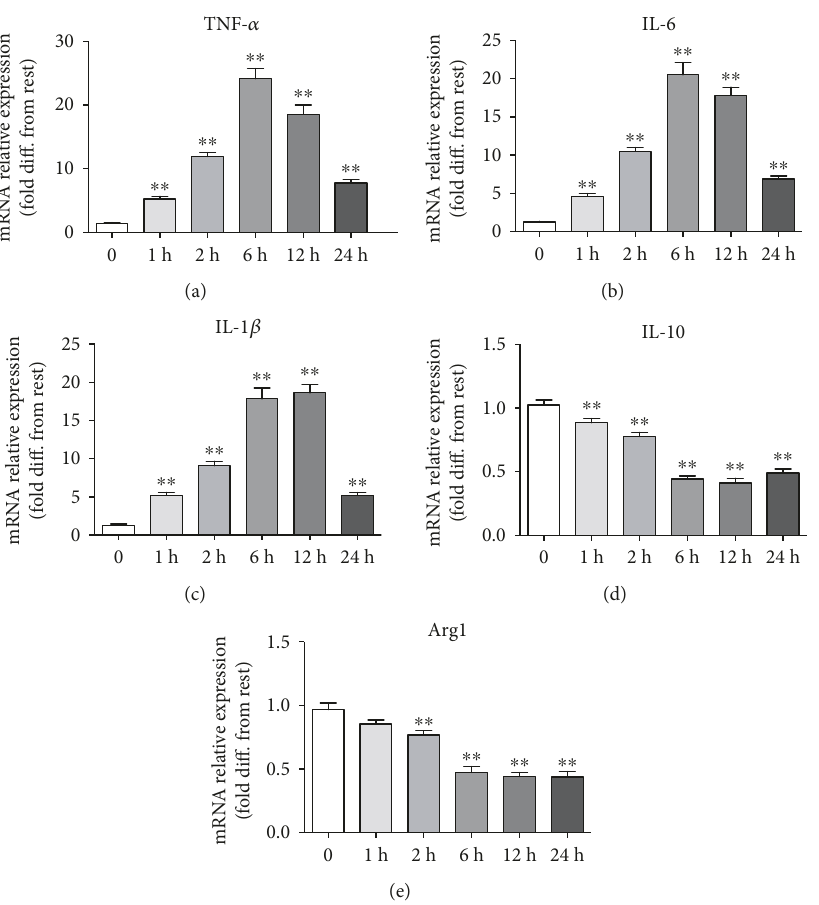
Figure 1: E ff ect of 100 ng/mL LPS on TNF- α , IL-6, IL-1 β , IL-10, and Arg1 gene expression in primary microglia ( ∗∗ P < 0 01 versus control group, each data represents the mean ± SEM of at least three separate experiments).